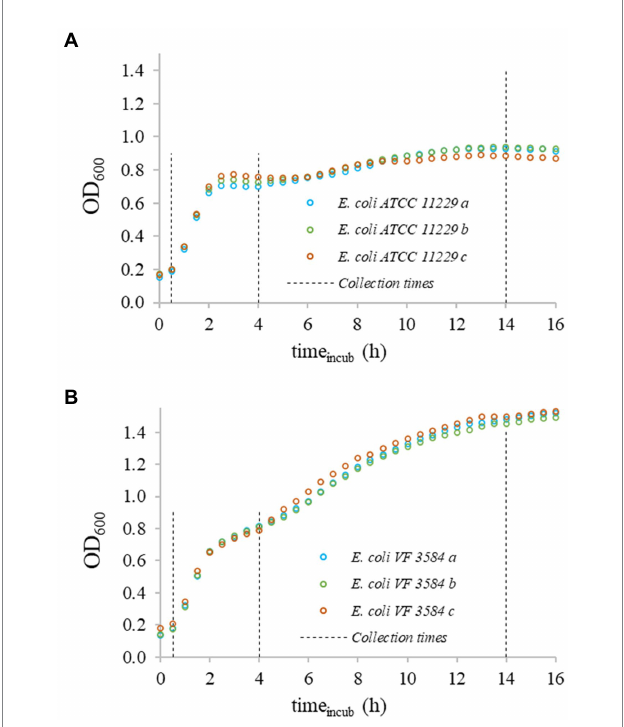
FIGURE 1 OD 600 growth curves of bacteria in triplicates recorded at 37 ° C. Uppercase letters indicate the different strains: (A) Escherichia coli ATCC 11229 and (B) E. coli VF 3584; lowercase letters specify the three replicates. The starting concentration of suspensions was ≈ 10 8 CFU/ml. Data points were shifted to an initial OD 600 = 0.1 value for all